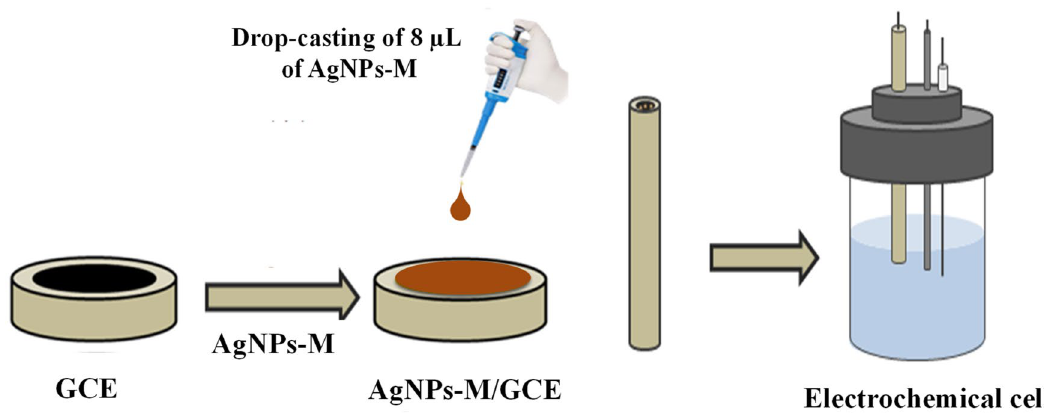
Figure 9. The fabrication process of AgNPs-M/GCE